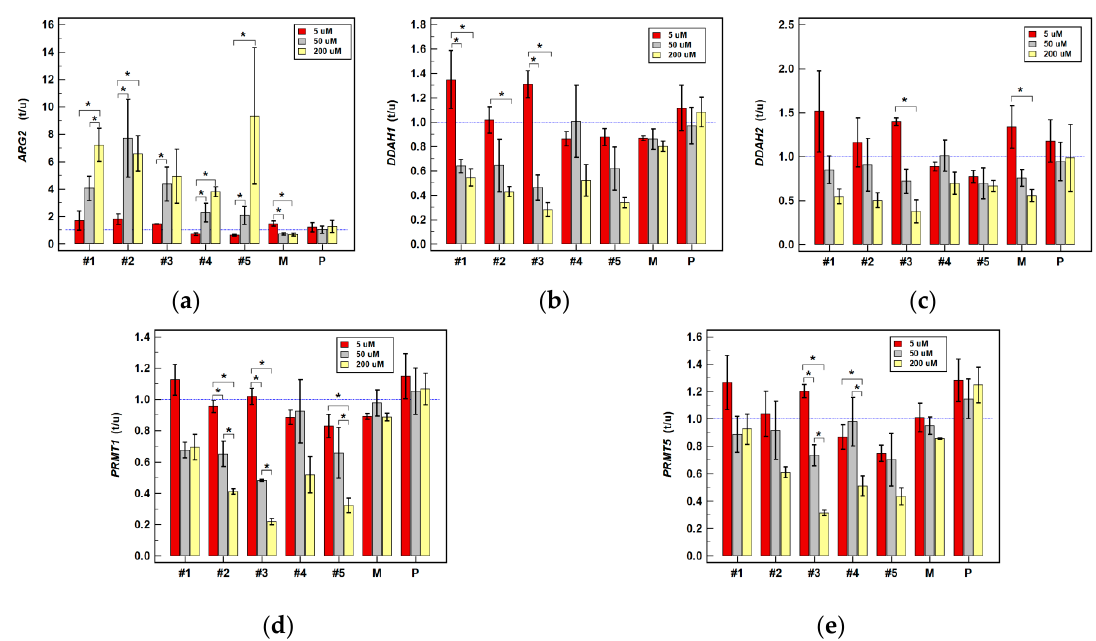
Figure 7. Dose-dependent e ff ect of oxicams on enzyme gene expression in HT-29 cells stimulated with 5, 50 and 200 µ M drug concentrations for 24 h: ( a ) Arginase-2 ( ARG2 ); ( b ) Dimethylarginine dimethylaminohydrolase-1 ( DDAH1 ); ( c ) Dimethylarginine dimethylaminohydrolase-2 ( DDAH2 ); ( d ) Protein methyltransferase-1 ( PRMT1 ); ( e ) Protein methyltransferase-5 ( PRMT5 ). Bars represent mean ( n = 3) concentration ratios treated-to-untreated cells (t / u) with standard deviation (whiskers). No e ff ect is marked by horizontal blue reference line. Data were analyzed using one-way analysis of variance. * significant between-group di ff erences; #1–5, oxicam analogues; M, meloxicam; P,